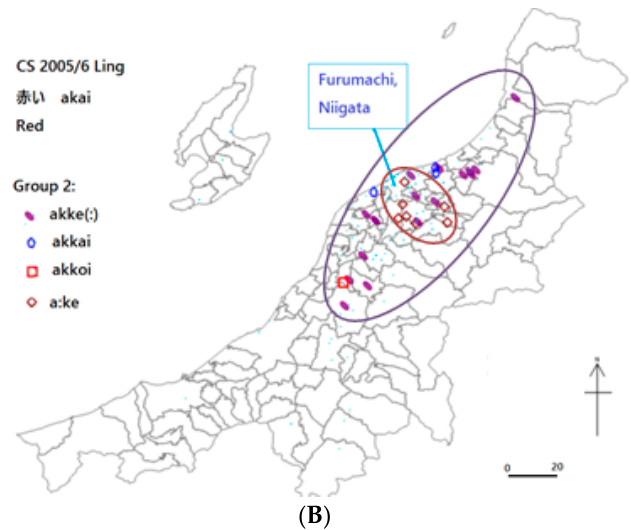
Figure 2. ( A ) Map (Group 1) of akai “red” in Niigata: 2005/6 CS Survey. ( B ) Map (Group 2) of akai “red” in Niigata: 2005/6 CS Survey.